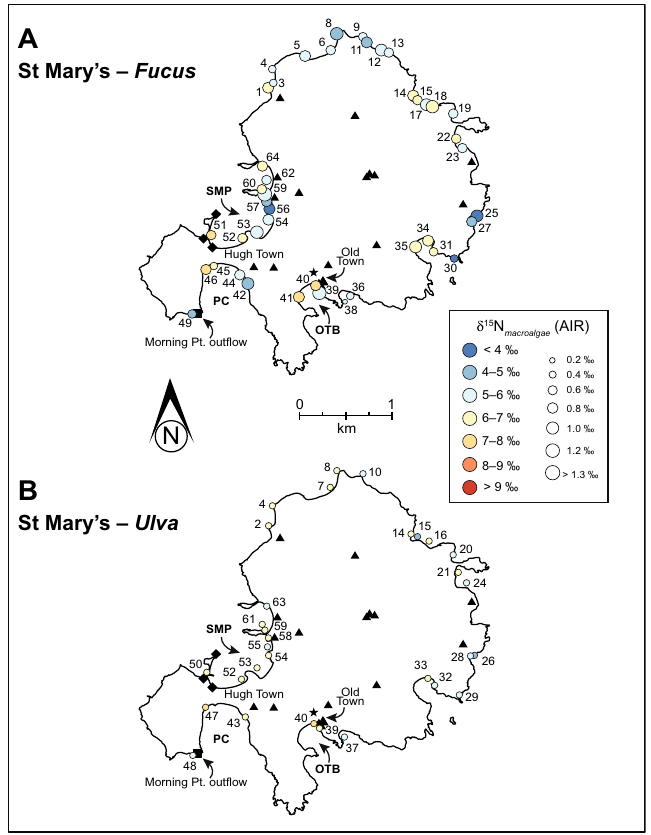
Figure 4. δ 15 N isoplot map for the macroalgae, Fucus ( A ) and Ulva ( B ) around St Mary’s, Isles of Scilly. Colour range represent distinct δ 15 N value ranges, while the size of the circle represents the standard deviation of δ 15 N from each site. In comparison to Jersey, macroalgae δ 15 N values are not as elevated (e.g., with dark orange or red circles) on St Mary’s: most likely related to the lower population size, release of untreated sewage/effluent and/or the islands reliance on a septic tank/soakaway system. Elevated macroalgae δ 15 N values are recorded for Morning Point, Hugh Town and Old Town regions. For abbreviations refer to Fig.